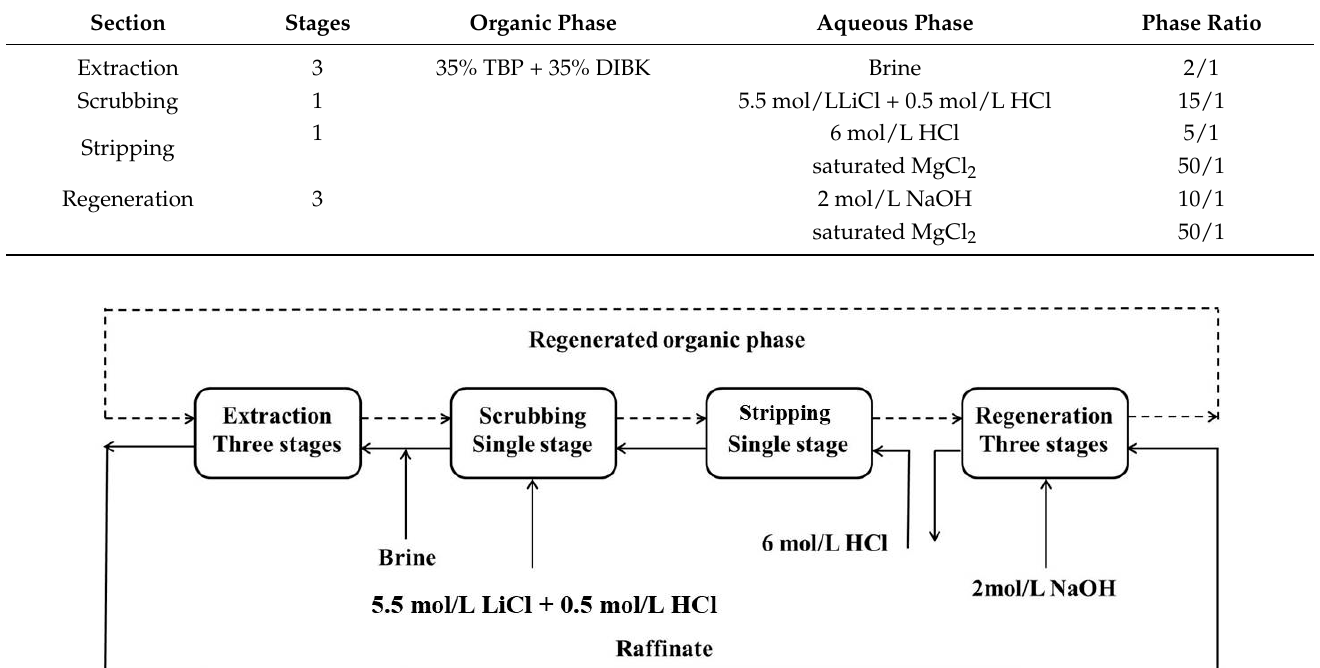
Table 4. Operation conditions of counter-current extraction.